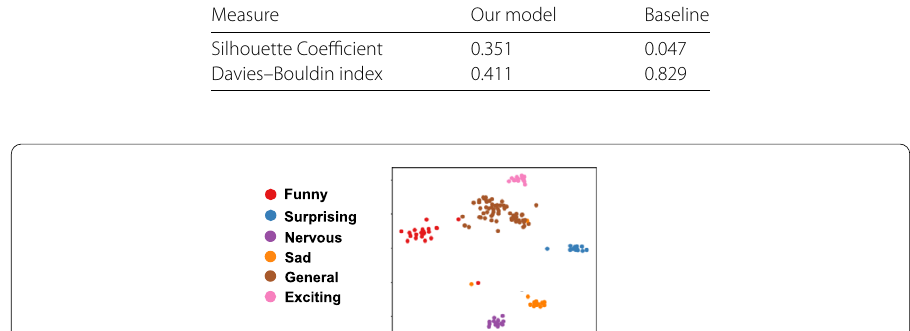
each identified cluster contains similar-looking emotes even though a visual feature has not been incorporated. The representative word tokens for each cluster suggest that the clustered emote expressions are related to the emotional expressions of the text. For ex- ample, the orange-colored cluster tends to contain emotes of crying faces (e.g.,